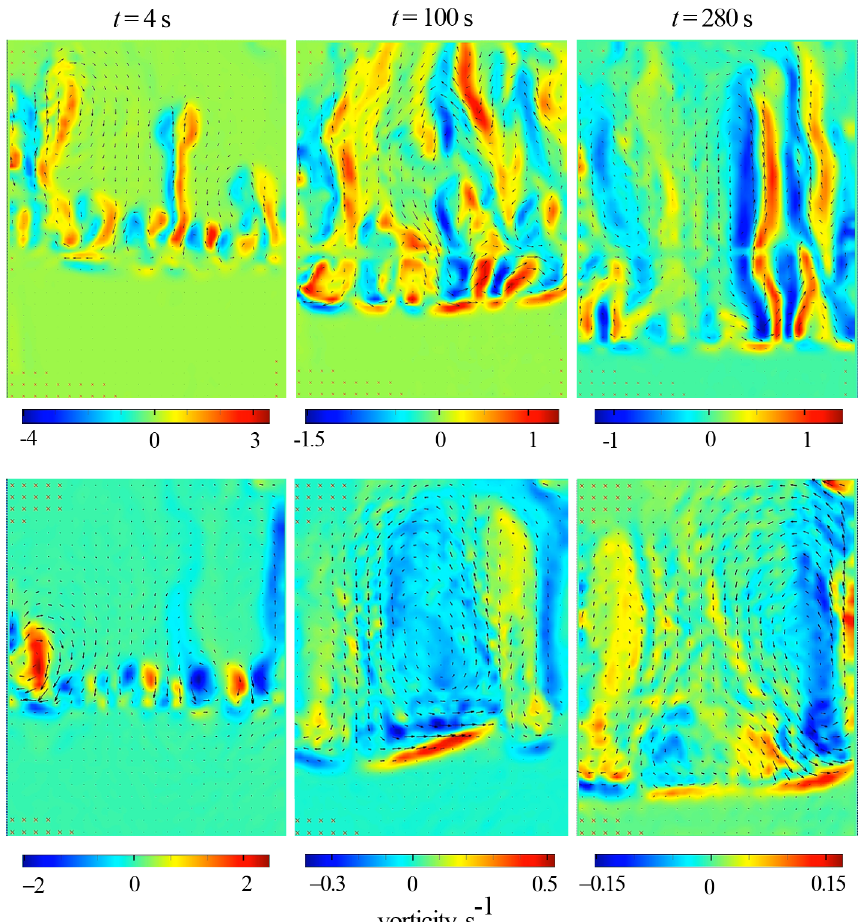
Figure 6. Time evolution of the vector plot of the time-average fluid velocity obtained by PIV at α = 0 ◦ (top row) and α = 70 ◦ (bottom row). The color maps represent the vorticity of the time- averaged velocity. The slot width is 5 cm. Each row presents the plots obtained for successive times: 4, 100, and 280